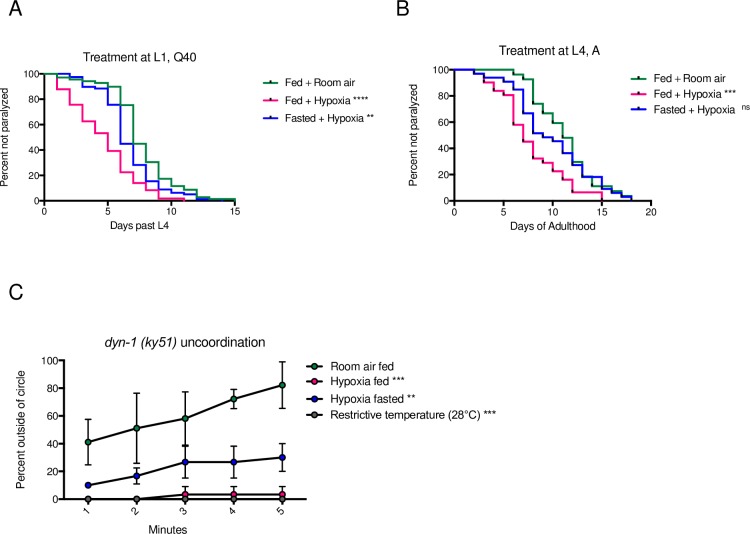
Fasting has general protective effects against hypoxia-induced defects in proteostasis.A. Fasting protects against toxicity of Q40::YFP. Cohorts of L1 animals expressing Q40::YFP were exposed to hypoxia on food (magenta), or fasted (blue) before exposure to hypoxia (F = 6h, H = 24 h). Paralysis was scored after return to room air, beginning the first day of adulthood. Controls remained on food in room air (green). Data from one representative experiment is shown, each cohort included at least 70 animals. Each experiment was repeated at least 3 times. Significance was calculated using a Log-rank (Mantel-Cox) test with a Bonferroni correction for multiple comparisons. Statistical comparisons were made between animals exposed to hypoxia and animals maintained in room air. **** p < 0.0001; ** p < 0.01. B. Fasting protects against toxicity of Aβ1–42. Cohorts of L4 animals expressing Aβ1–42 were exposed to hypoxia on food (magenta) or fasted (blue) before exposure to hypoxia (F = 6h, H = 24h). Paralysis was scored after return to room air, beginning at the first day of adulthood. Controls remained on food in room air (green). Data from one representative experiment is shown, each cohort included at least 70 animals. Each experiment was repeated at least 3 times. Significance was calculated using a Log-rank (Mantel-Cox) test with a Bonferroni correction for multiple comparisons. Statistical comparisons were made between animals exposed to hypoxia and animals maintained in room air. *** p < 0.001. C. Fasting protects against hypoxia effects on metastable DYN-1. Temperature-sensitive dyn-1(ky51) mutant animals were exposed to hypoxia at the permissive temperature on food (magenta), or after fasting (blue). Controls remained on food in room air at the permissive temperature (green) or on food at the non-permissive temperature (28°C, gray). Paralysis was scored 1h after return to room air. Average data from 3 independent experiments is shown, each cohort included 10 animals. Significance was calculated using a repeated measures two-way ANOVA and Dunnett’s multiple comparisons test. Statistical comparisons were made between animals exposed to hypoxia or animals maintained at the restricted temperature and animals maintained in room air. Significance: *** p < 0.001; ** p < 0.01. Summary statistics for replicates from all experiments are in S4 Table.